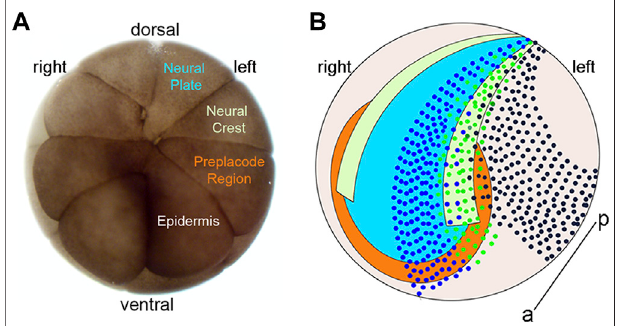
FIGURE 1 | Blastomere fate map and location of clones at neural plate stages. (A) Animal view of a 16-cell Xenopus laevis embryo indicating the major precursors of the neural plate (blue), neural crest (light green), pre- placode region (PPR; orange) and epidermis (light brown) on the embryo ’ s left side. (B) Cartoon of the ectodermal domains at the neural plate stage with dorsal to the top, anterior to the front, and the anterior-posterior axis (a – p) indicated by a line. Dark blue dots indicate a clone of cells derived from aleftblastomere injectionthatoccupies theleftneuralplate(blue)and left anterior PPR (orange). Green dots indicate a clone of cells derived from a left blastomereinjection thatoccupiestheleftneuralplateborder includingtheleft neural crest (light green) and left posterior PPR (orange). Dark brown dots indicate a clone of cells derived from a left blastomere injection that occupies the left dorso-lateral epidermis (light